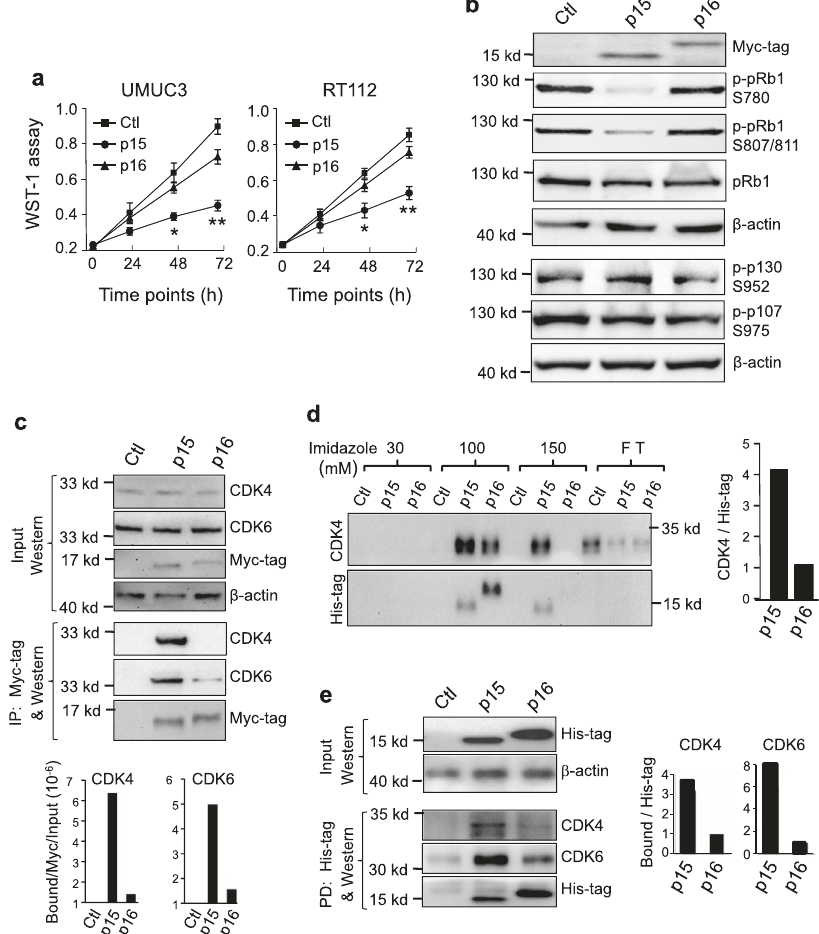
Fig. 4 Greater inhibition of proliferation by p15 than by p16 via their differential binding to CDK4 and CDK6. a Human bladder cancer cell lines, UMUC3 and RT112, both lacking endogenous p15 and p16, were stably transfected and induced to express either protein, using a two-vector, tetracycline-inducible system, followed by proliferation (WST-1 assay) at the indicated post-induction time points. Cell number was normalized by western blotting (as shown in b ). In a n = 4 of biologically independent samples. Data are presented as mean value±SD. Two-sided t -test was performed to compare the signi fi cance of the difference between the two groups (p15 versus p16). The P values are: for UMUC3: (*), 1.3E-4; (**), 3.5E-5; and for RT112: (*) 0.0019 and (**) 8.8E-5. Note only a relatively small inhibition of proliferation and cell-cycle progression by p16 expression and a much greater inhibition by p15 expression. b Western blotting of key cell-cycle regulators of transfected UMUC3 cells analyzed 24h after the induced expression of p15 or p16, showing the marked inhibition of pRb1 phosphorylation by p15 and much less so by p16, and that p15 did not affect the phosphorylation of other pRb family proteins p130 or p107. n = 3 per genotype indicated at the top. c – e Differential binding of p15 and p16 to CDK4 and CDK6. c Immunoprecipitation. UMUC3 cells were stably transfected and induced by tetracycline to express Myc-tagged p15 or Myc-tagged p16, followed by immunoprecipitation using anti-Myc-tag antibody and then western blot detection of co-immunoprecipitated proteins. The lower panels were representative semi-quantitation by densitometry of immunoprecipitated CDK4 and CDK6 by p15 or p16 in reference to the Myc-tag (middle panels) and input (top panels). The experiments were repeated three times with similar results. Note that, with equivalent amounts, p15 immunoprecipitated signi fi cantly more CDK4 and CDK6 than p16. d Pull-down assay. Histidine-tagged p15 or p16 produced by recombinant E. coli were immobilized on nickel columns and incubated with total protein extracts from untransfected, parental UMUC3 cells. Bound proteins were eluted by increasing concentrations of imidazole and detected by western blotting. The right panel was a representative semi- quantitation by densitometry of pulled-down CDK4 by p15 or p16 at 100 mM imidazole in reference to the His-tag. The experiments were repeated twice with similar results. Note that, proportionally, with 100 mM imidazole, p15 pulled down signi fi cantly greater amounts of CDK4 than p16. e An independent experiment similar to that described in d , showing greater amounts of CDK4 and CDK6 were pulled down by p15 than by p16. The right panels were representative semi-quantitation by densitometry of pulled-down CDK4 and CDK6 by p15 or p16 in reference to the His-tag. The experiments were repeated twice with similar results. Source data are provided as a Source Data fi CDK6, respectively, with p15 as a bait, compared to p16 as a bait recombinant, histidine-tagged p15 or histidine-tagged p16 in E. (Fig. 4e). coli , conjugating either protein to nickel columns, and incubating them with total proteins extracted from untransfected, parental The N terminus of p15 mediates the strong binding of p15 to CDK4 and CDK6 . p15 and p16 are highly homologous (69% identity in amino acid sequences) with the exception of their N- termini (N) and the longer C terminus (C) unique to p16. To discern the region responsible for the strong interaction between